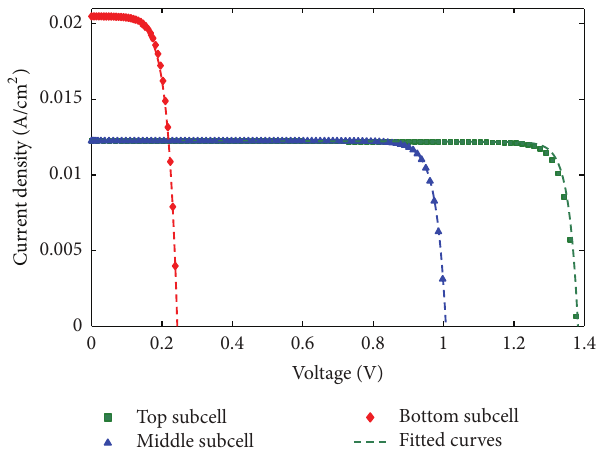
Figure 2: Simulated subcell J-V data for the TJSC obtained using TCAD Sentaurus (at 300 K and 1 sun) along with the least-squares, curve-fitted data.